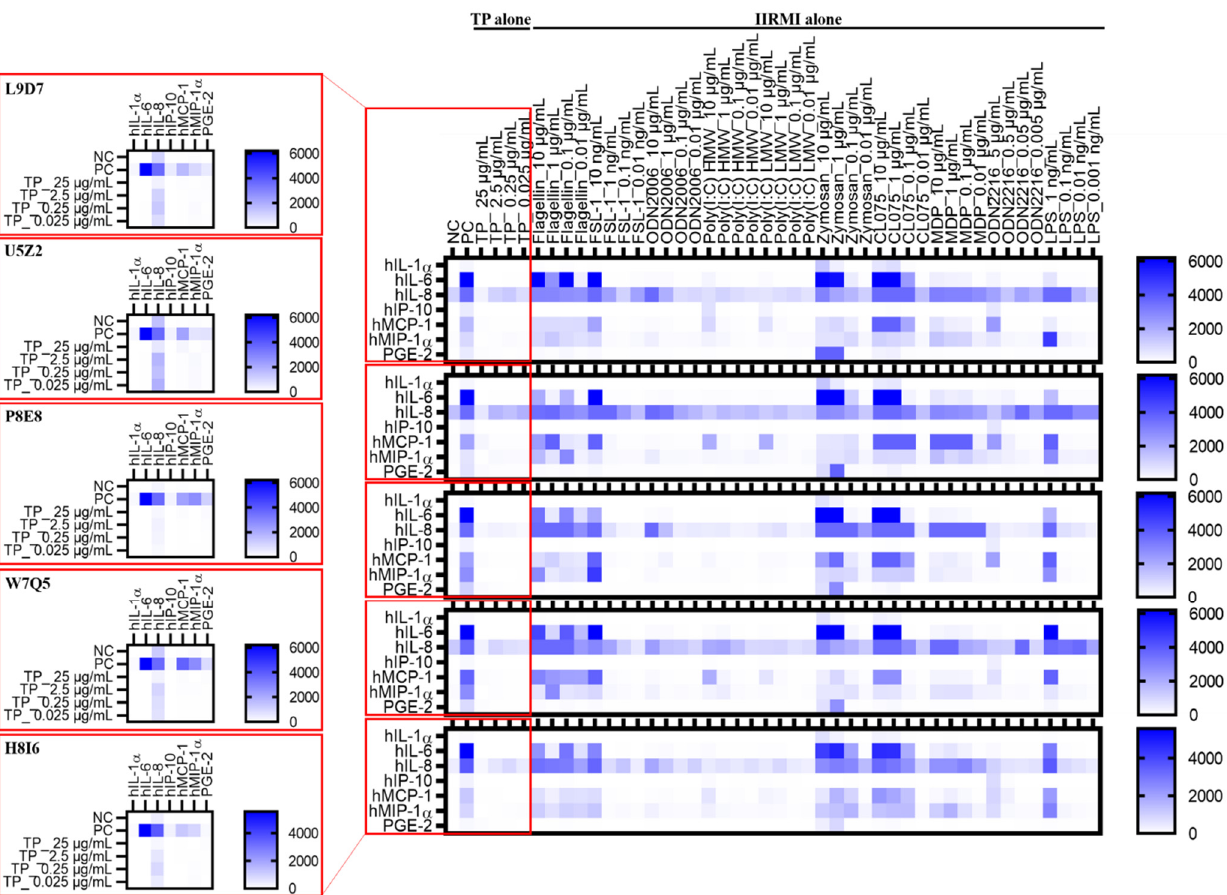
Figure 5. Seven-plex Induction of Cytokines in PBMCs. PBMCs collected from 10 healthy human donors were treated with 0.025, 0.25, 2.5, and 25 μ g/mL TP (red box) or IIRMIs alone, compared to a PBS negative control (NC) and LPS/PHA- M/ODN positive control (PC), for 24 h. Supernatants were analyzed for the presence of cytokines by multiplex ELISA. Shown is the mean response (N = 2). Shown here are the data generated using PBMC cultures of five representative donors. The data generated using PBMCs of the remaining five donors are presented in Figure S11. Normalized data for each treatment set in all ten donors are also presented in Figure S12.